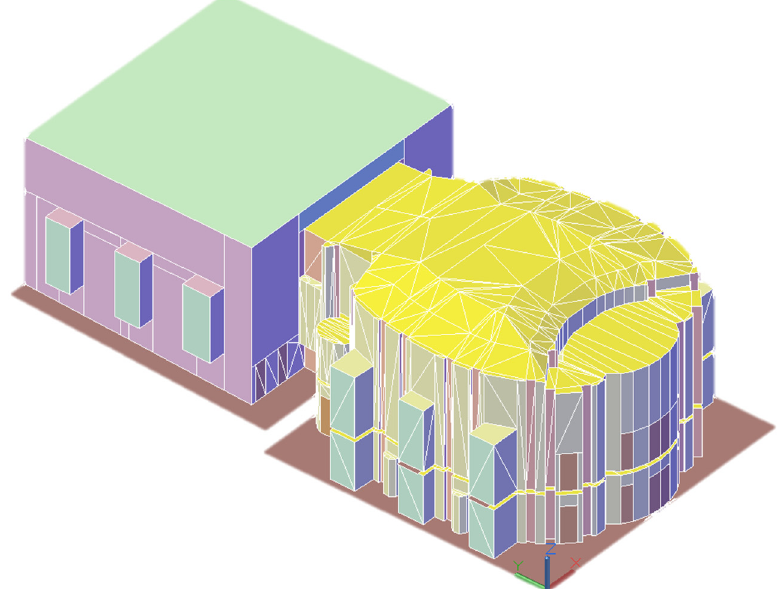
Figure 6. The 3D model of the Eszterháza Opera House.